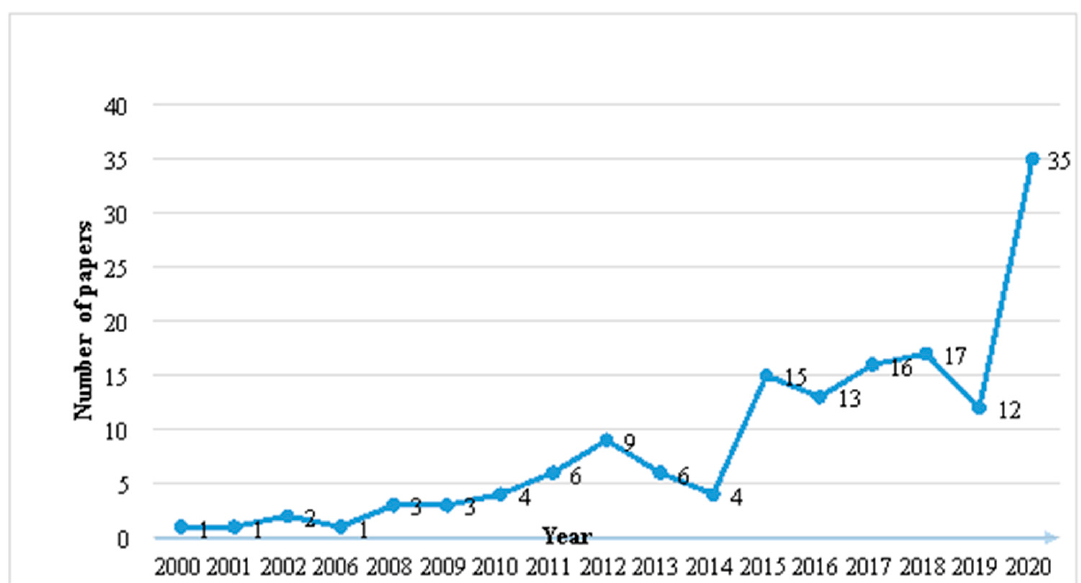
Figure 3. Papers based on the year of publication.